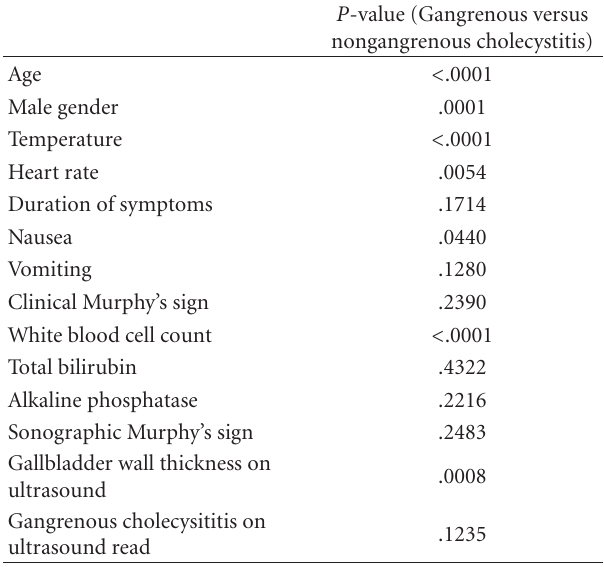
Table 1: Clinical data included in univariate